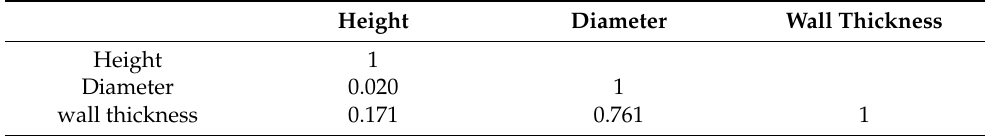
Table 8. Correlation